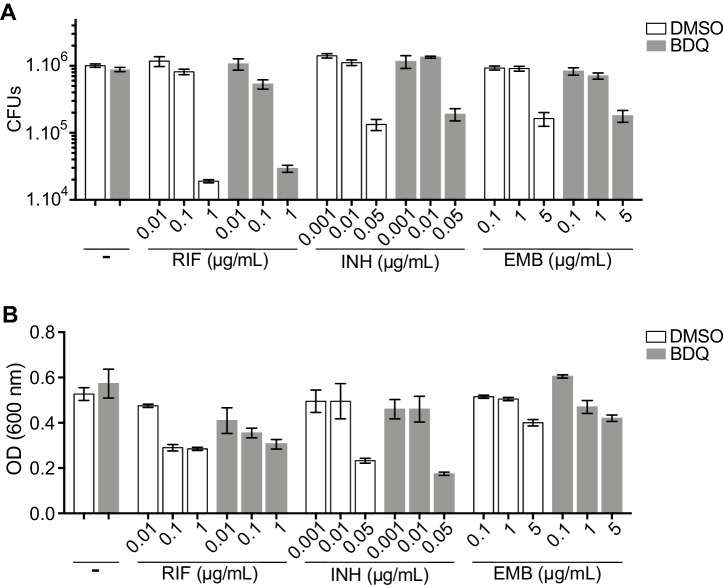
BDQ did not potentiate the activity of the other first-line anti-TB drugs, in liquid culture or in BDQr-MTB infected macrophages.(A) Cells were infected with BDQr-MTB and treated with BDQ (1 μg/mL) and RIF, INH or EMB. After 5 days treatment, cells were lysed and bacteria were enumerated by CFU (counted in triplicate). (B) Optical density (OD) measurements of bacterial growth of BDQr-MTB in the presence of BDQ (1 μg/mL) and different concentrations of RIF, INH and EMB. Bacteria were cultured in 7H9 medium supplemented with 10% OADC enrichment with/without the drugs during 5 days. One representative experiment (of at least three) is shown. Error bars represent the mean ± SD. *p<0.05, **p<0.01, ***p<0.001.